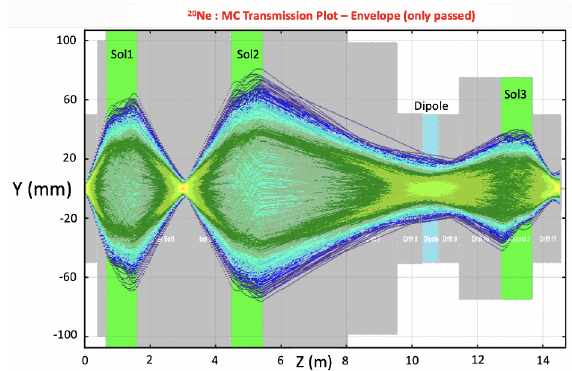
Figure 9. Calculated profile for a 50 MeV 20 Ne beam.